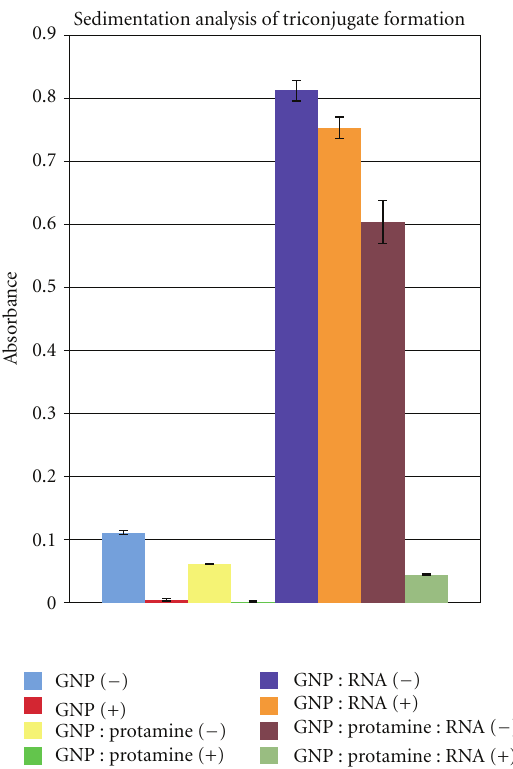
Figure 6: Loss of absorbance from the supernatant sedi- mentation analysis of GNP, GNP :protamine, GNP :RNA, or GNP:protamine:RNA; ± indicates before microcentrifuge spin ( − ) or after spin (+).